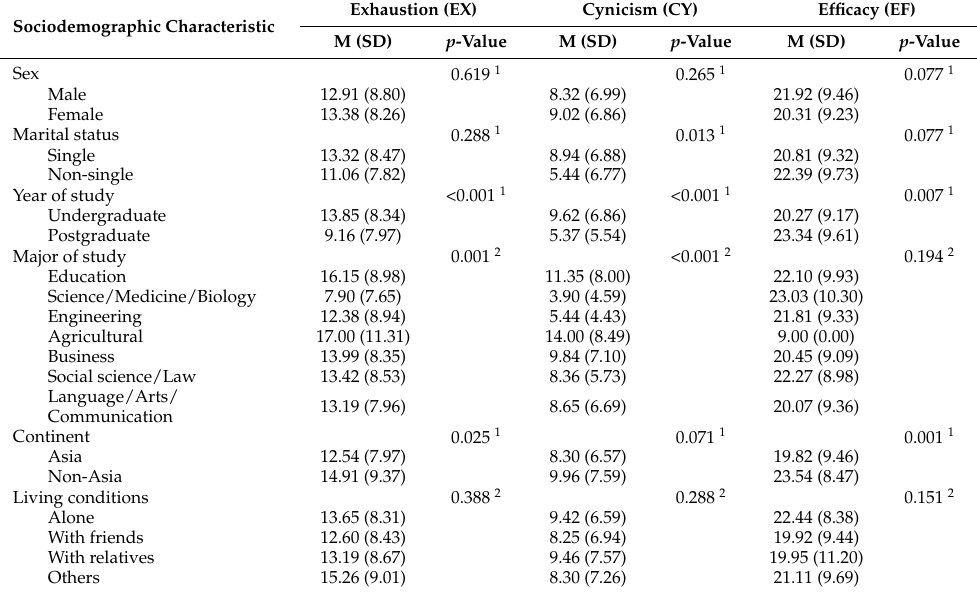
Table 3. Academic burnout scores across sociodemographic characteristics among respondents (N =